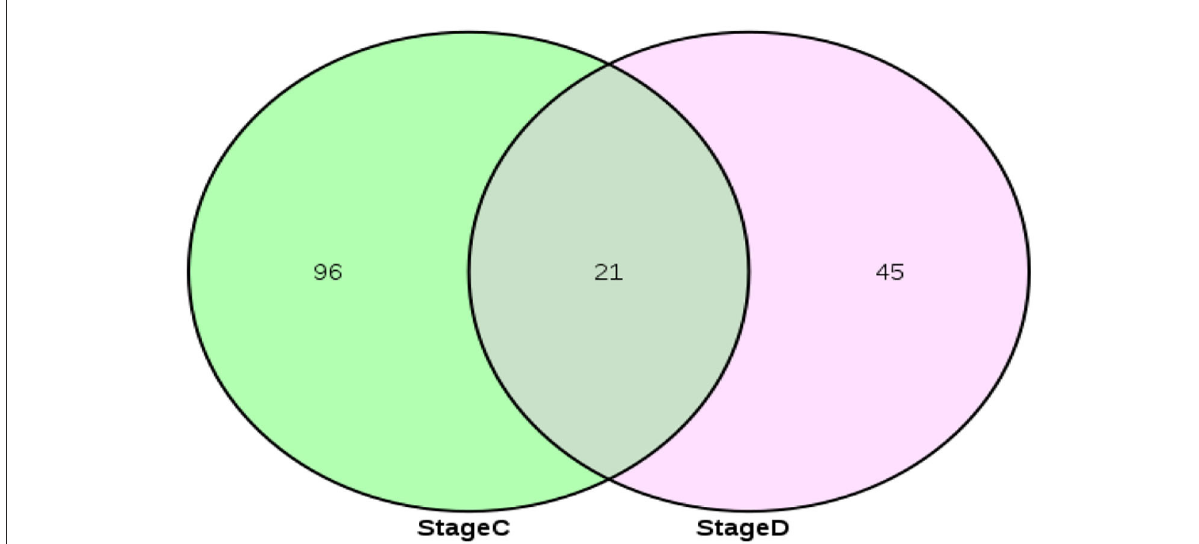
FIGURE4 Screening of key miRNAs in ceRNA regulatory network related to secondary hair follicle development.